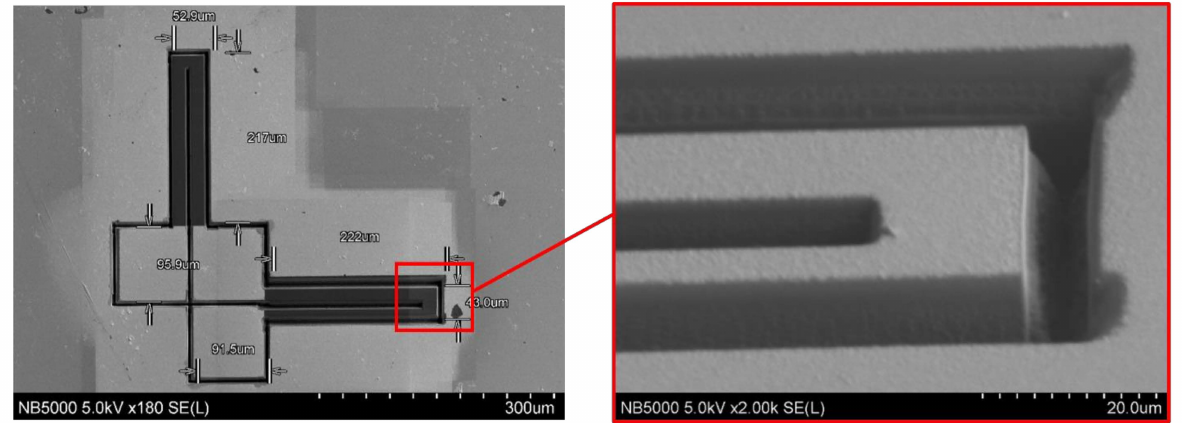
Figure 7. The structure of the designed sensor geometry cut by FIB.